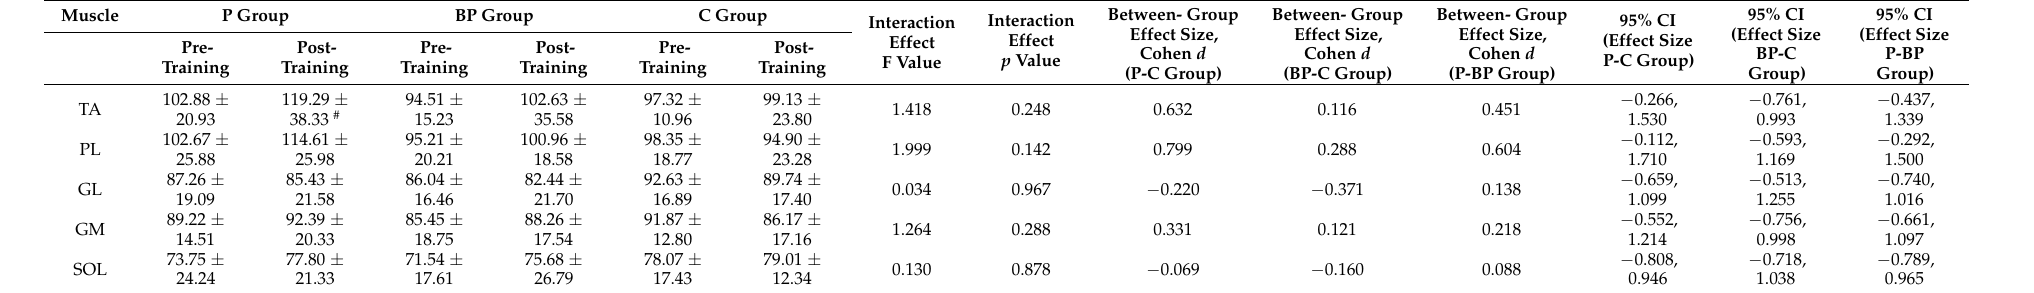
Table 3. Integrated EMG values of each group during post-landing phase of medial drop-landing task (unit: % •